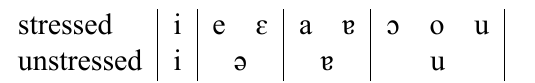
Table 19: Unstressed vowel reduction in European Portuguese